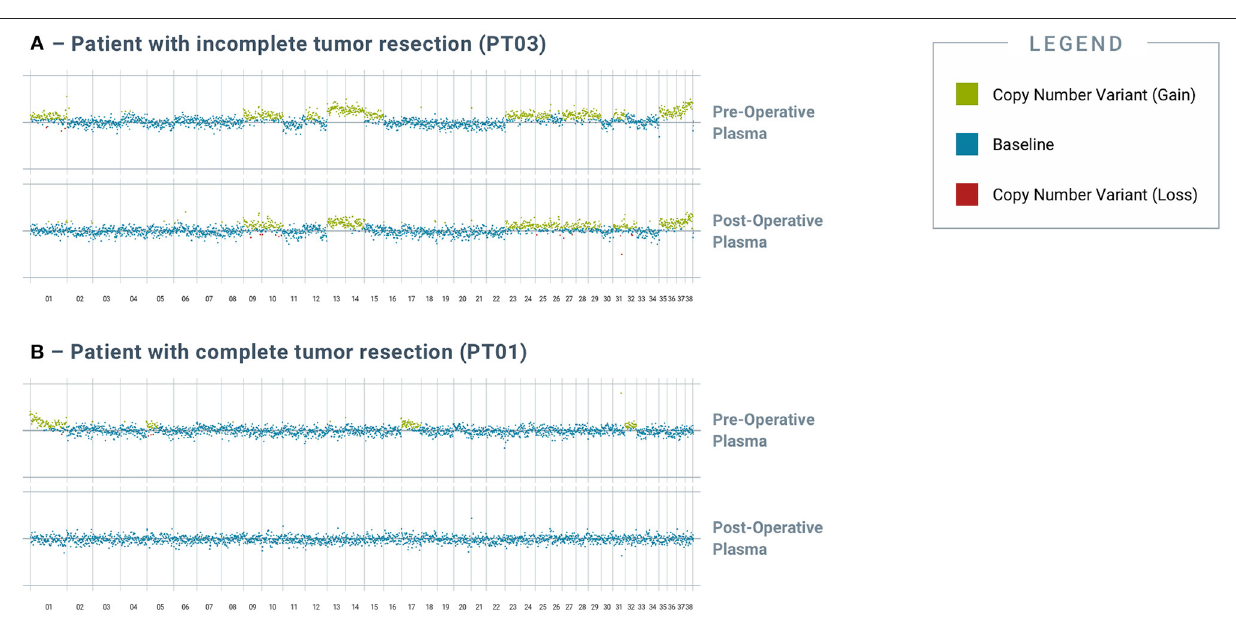
FIGURE 3 | Analysis of post-operative blood-derived plasma cfDNA reveals residual genomic alterations after incomplete resection of tumor. Genomic alterations were detected in post-op blood samples from tumors with incomplete tumor resection but not in those with complete resection. (A) depicts pre- and post-operative plasma CNV traces from PT03, a 14-year-old female spayed mixed breed dog that had incompletely excised metastatic pancreatic carcinoma. (B) depicts pre- and post-operative plasma CNV traces from PT01, a 12-year-old male intact West Highland White Terrier that had completely excised cystic renal carcinoma. All chromosomes shown were interrogated for cancer-associated genomic alterations by the